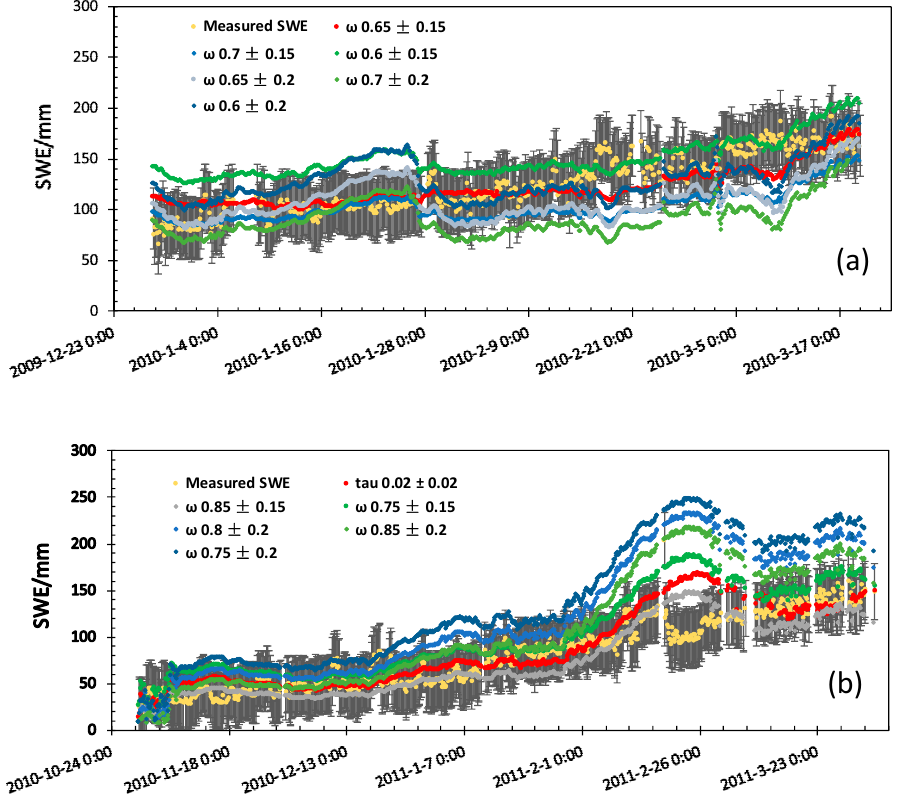
Figure 10. Retrieval using six different settings for the albedo reference values and variance values. Retrieved SWE ( red dots) in comparison to measured SWE ( yellow dots) with ±30 mm standard error ( black ) during: 27 December 2009–19 March 2010 ( a ); and 29 October 2010–4 April 2011 ( b ).